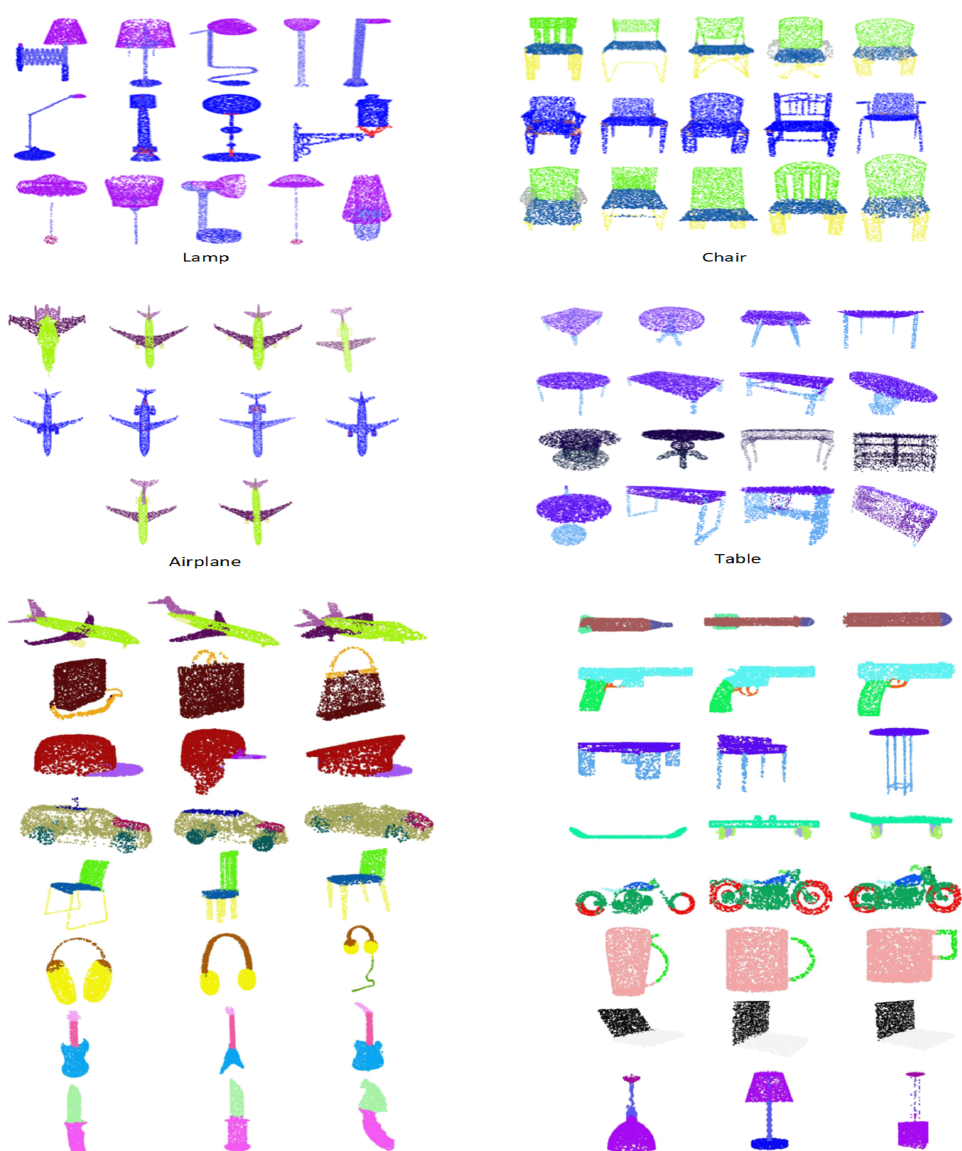
Figure 8. Results of part segmentation on different object